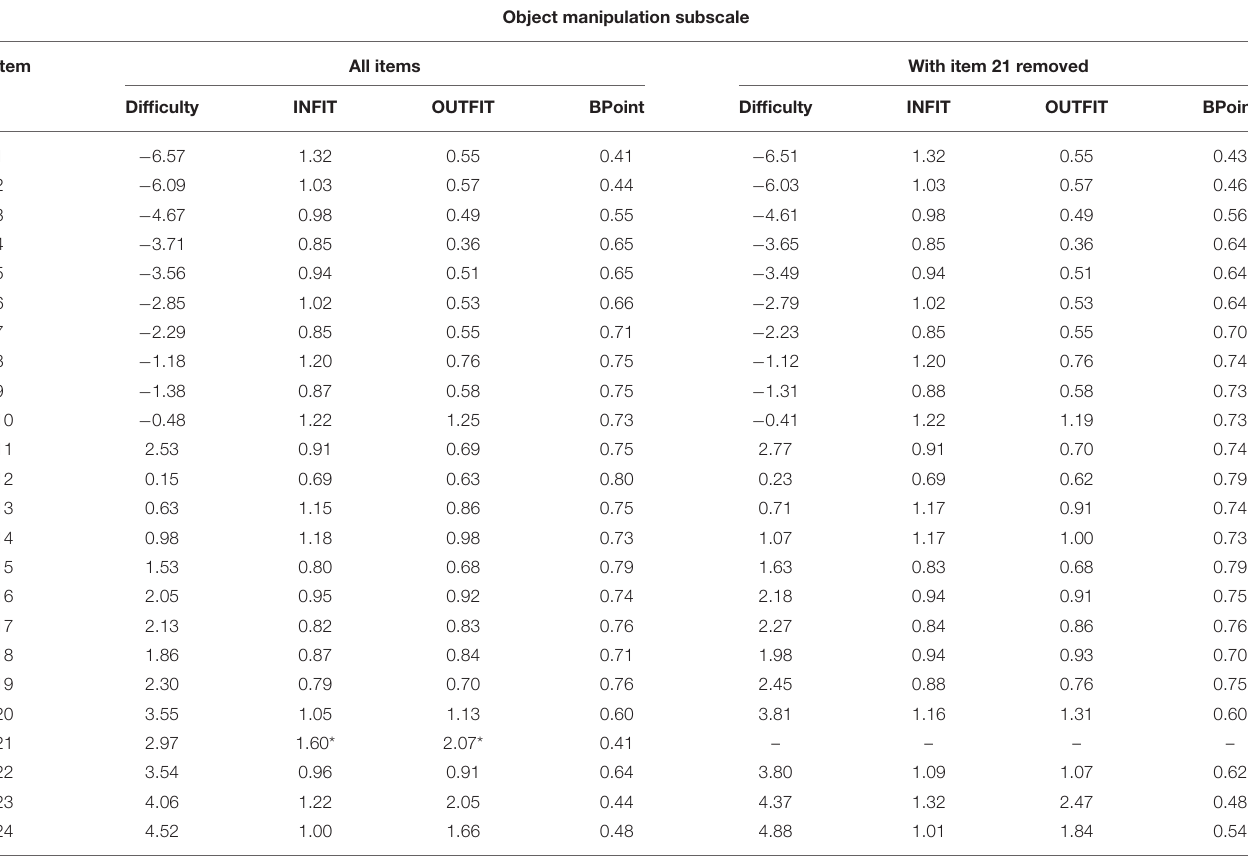
TABLE 5 | Object manipulation subscale: item difficulty, INFIT, OUTFIT, and point-biserial correlations before and after removing items. Object manipulation